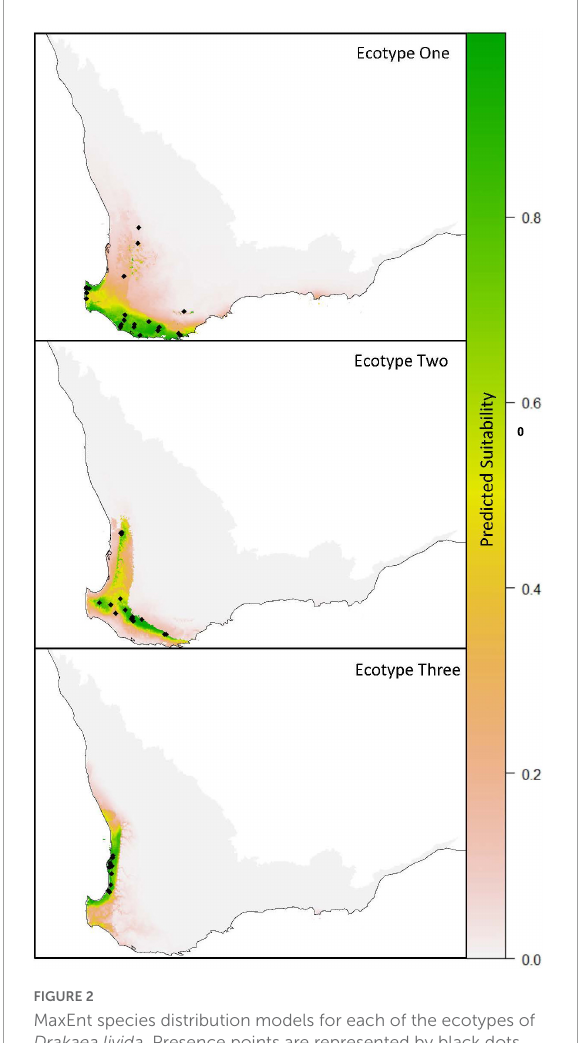
FIGURE2 MaxEnt species distribution models for each of the ecotypes of Drakaea livida . Presence points are represented by black dots. Gray denotes the extent of the model prediction area.